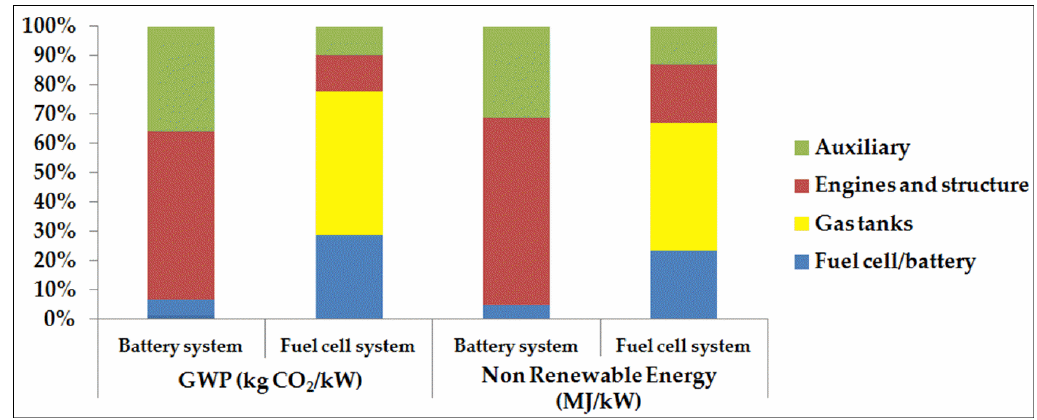
Figure 10. Impact distribution for the main components of the mobile systems for global warming potential and non-renewable energy.